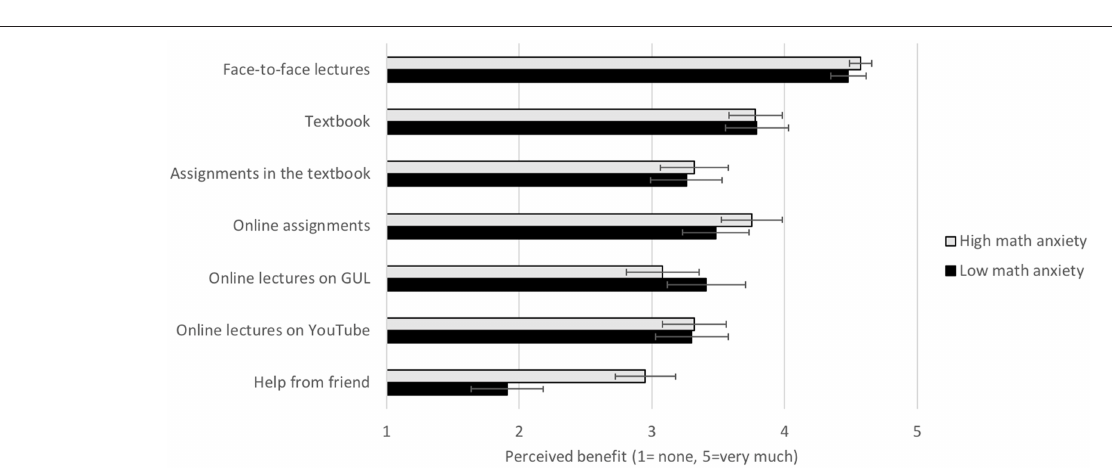
Frontiers in Education |